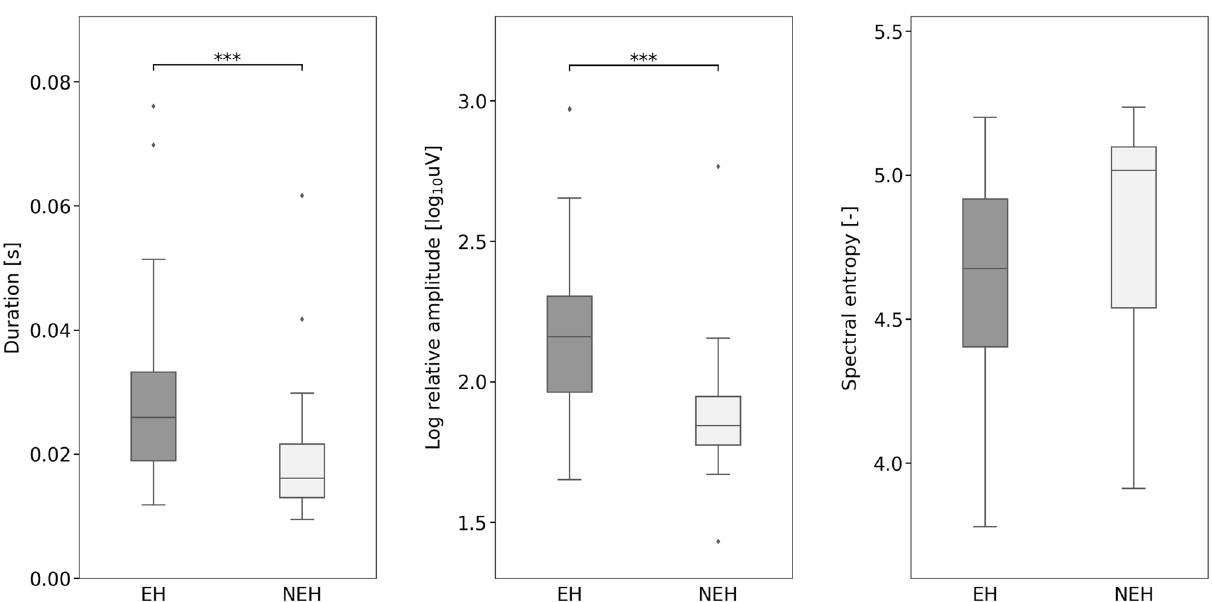
Figure 4. Fast ripple duration, relative amplitudes and spectral entropy during resting periods within the epileptic and non-epileptic hippocampi across all investigated subjects. Black asterisks indicate significant differences ( p < 0.001). Black diamonds indicate